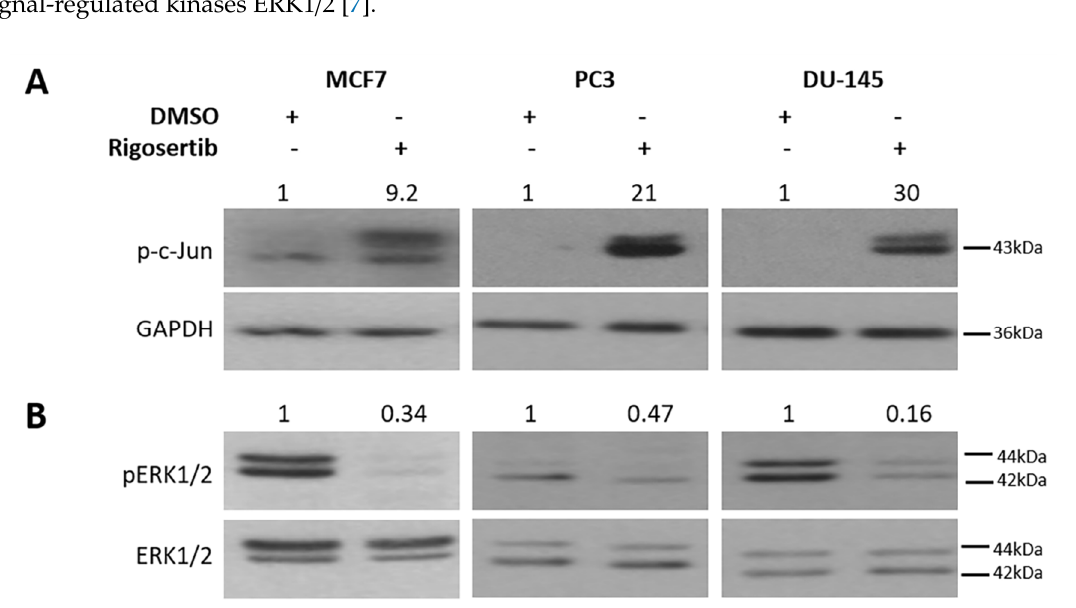
Figure 1. Effect of Rigosertib on MAPK signaling. Representative Western blots show an increase in cJun N-terminal kinases 1/2 (JNK1/2) ( A ) and a decrease in ERK1/2 activity ( B ) in MCF7, PC3, and DU-145 cells stimulated with 50 µ M Rigosertib for 18 h. Numbers on top of the blot indicate the fold change in protein phosphorylation upon Rigosertib treatment (normalized to loading control) relative to DMSO (solvent)-treated control samples. All experiments have been repeated at least three times with consistent results. A representative blot is shown.